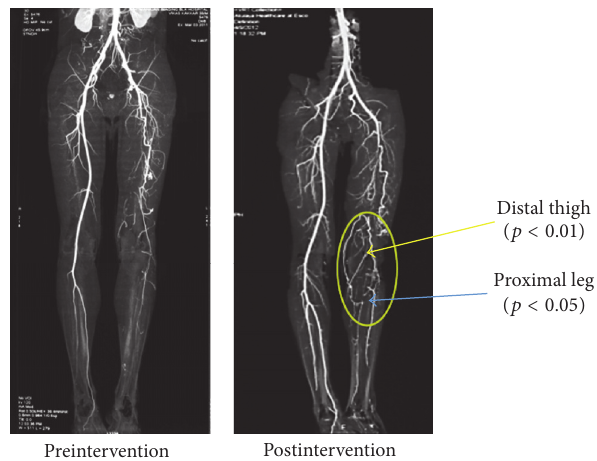
Figure 9: CT Angiography images showing qualitative analysis of degree of